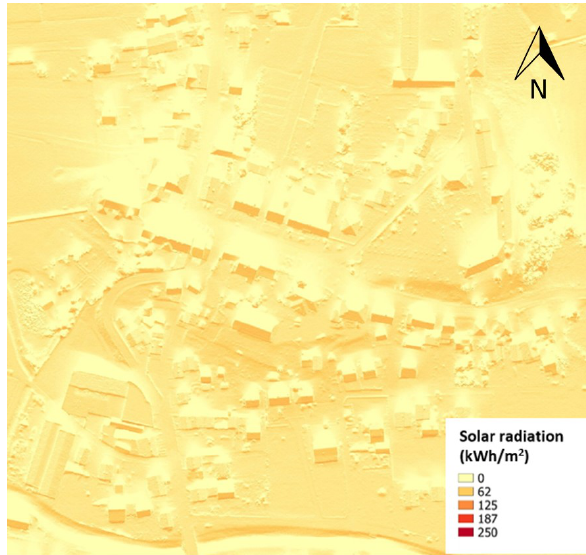
Figure 6. Solar potential of the test area for